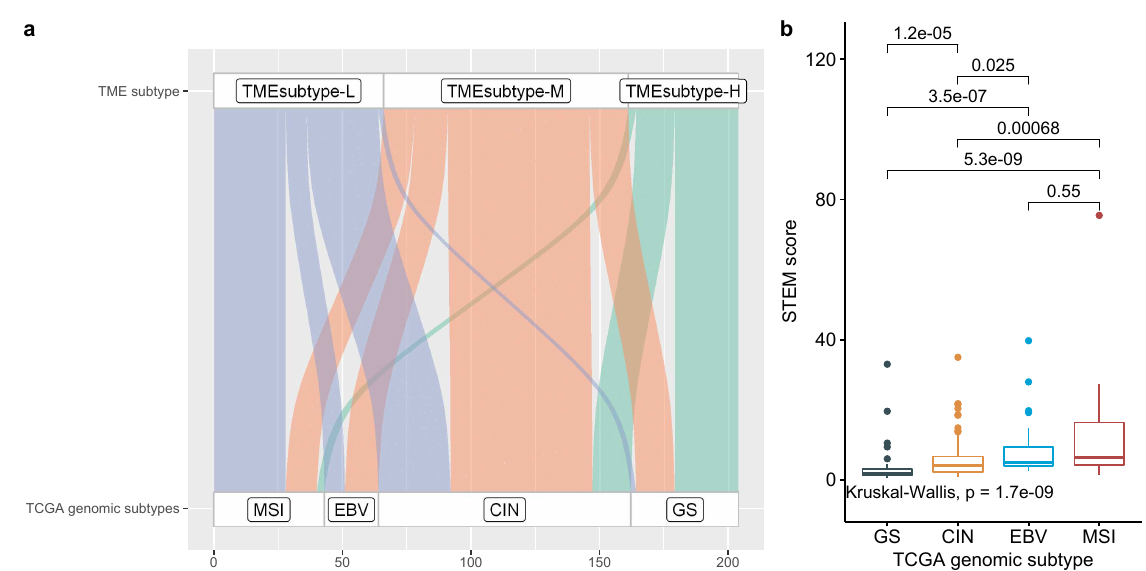
Figure 21. Association of TME subtypes and TCGA genomic subtypes. ( a ) Alluvial plot displaying the association of TME subtypes and TCGA-STAD subtypes. ( b ) Comparison of STEM score across four TCGA genomic